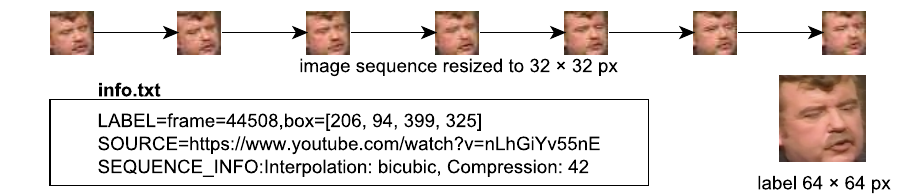
Figure 4. An example of sample data. Seven low-resolution images (32 × 32px) and label (64 ×